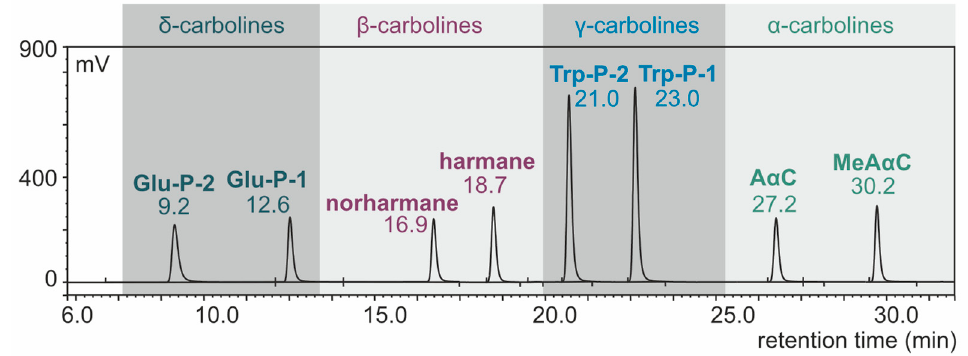
Figure 1. HPLC-FLD chromatogram of carboline standard mixture (concentration: 1 ng/ µ L, injection: 2.5 µ L).